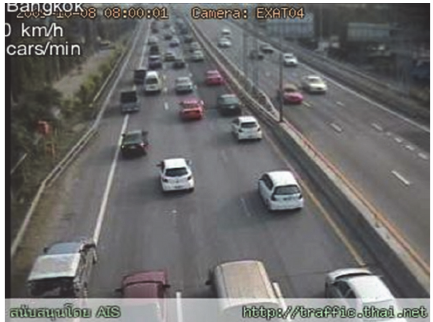
Figure 6: An image of a traffic delay occurrence captured at the 4th camera